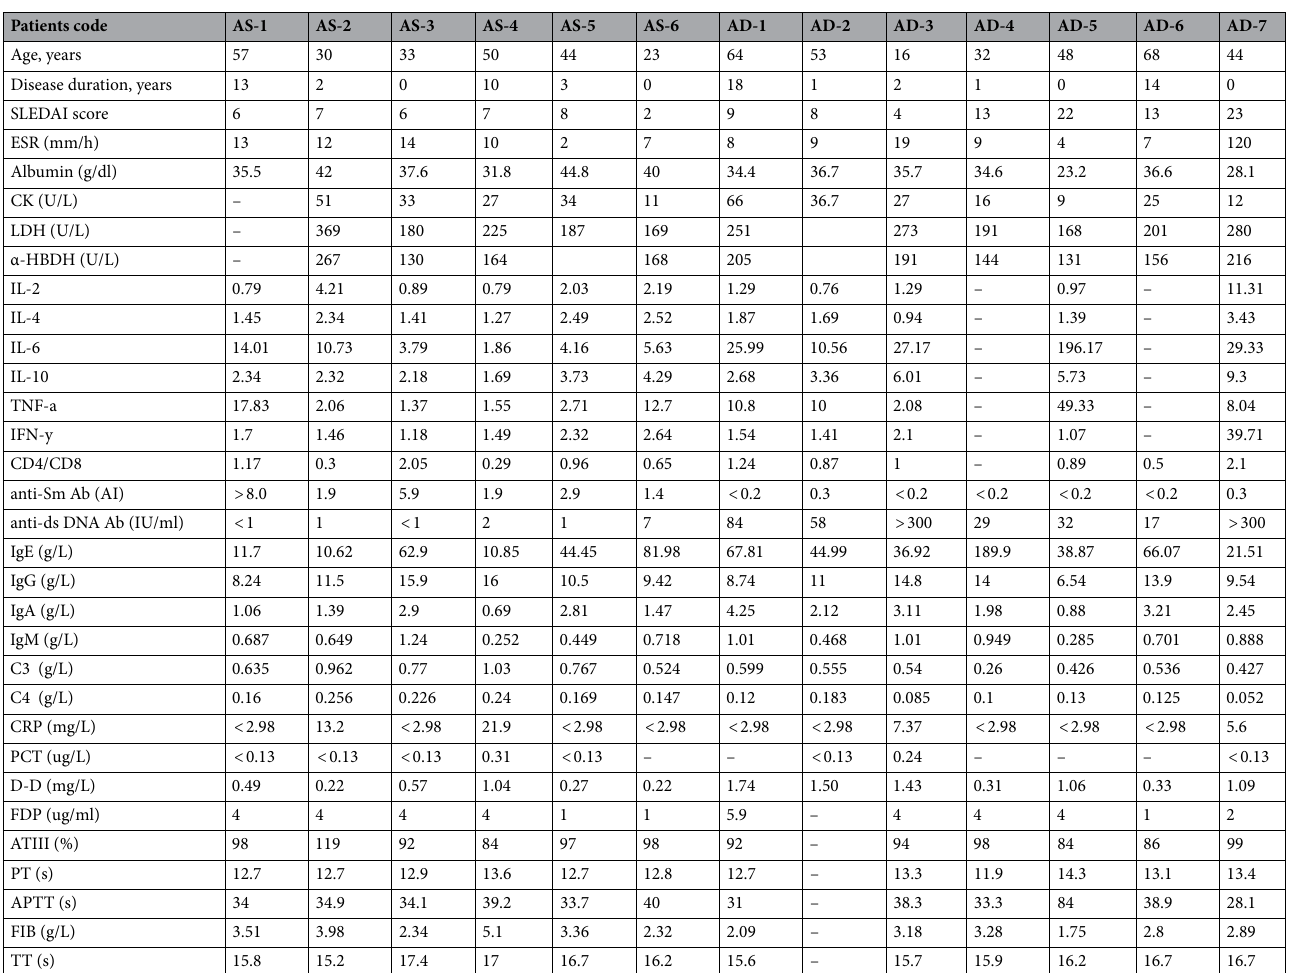
Table 1. Clinical, biochemical, and laboratory data for the 13 enrolled SLE patients. AS anti-Sm antibodies (+), AD anti-dsDNA antibodies (+), U-LEU urinary leukocyte, FDP fibrin degradation product,